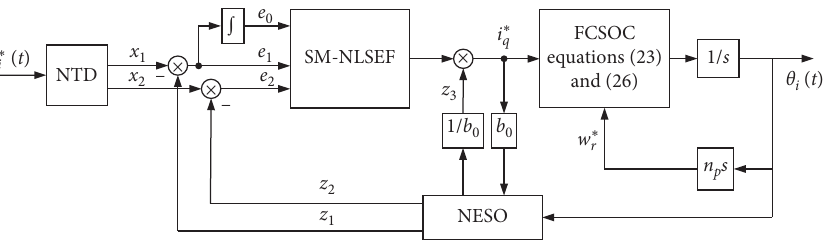
Figure 2: Structure of the SADRC-FCSOC